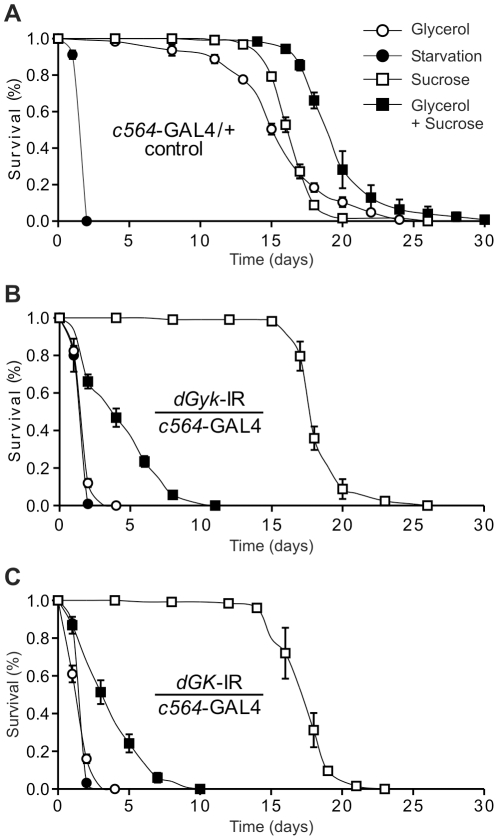

dGyk- and dGK-knockdown flies are hypersensitive to glycerol.When placed on a glycerol only diet, both dGyk-IR/c564-GAL4 and dGK-IR/c564-GAL4 flies died at a similar rate to starvation (control flies were relatively glycerol tolerant). RNAi flies had relatively normal survival on sucrose media compared to controls, but were intolerant to glycerol+sucrose media indicating hypersensitivity to glycerol. Survival analysis of 7-day old male RNAi flies was performed on defined media: glycerol (open circle); starvation (filled circle); sucrose (open square); glycerol+sucrose (filled square). Genotypes tested were (A) control flies, w1118; c564-GAL4/+, (B) w1118; dGyk-IR/c564-GAL4, (C) w1118; dGK-IR/c564-GAL4. Survivorship assays using parental construct control flies were also performed but were not found to be glycerol hypersensitive. For each genotype and media type, percentage survivorship ± standard error was calculated from 5 vials of 20–25 flies. Survival analysis was performed using the log-rank test on the Kaplan and Meier data.